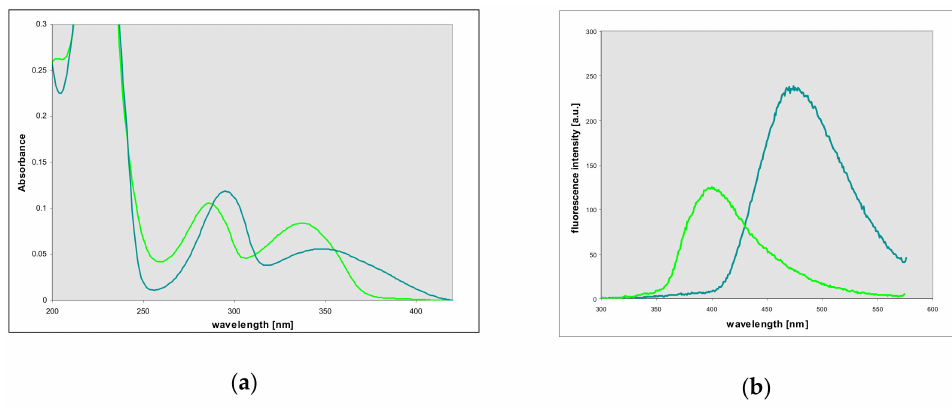
Figure 7. Comparison of ( a ) absorption and ( b ) fluorescence spectra of two ribosides of 1,N 2 -etheno-2-aminopurine ( 3 and 4 ), obtained chemically ( 3 , dark green curves) and enzymatically 4 , using E. coli PNP as a catalyst (bright green curves). Spectra measured in phosphate bu ff er, pH 7. Fluorescence excitation is at 290 nm.